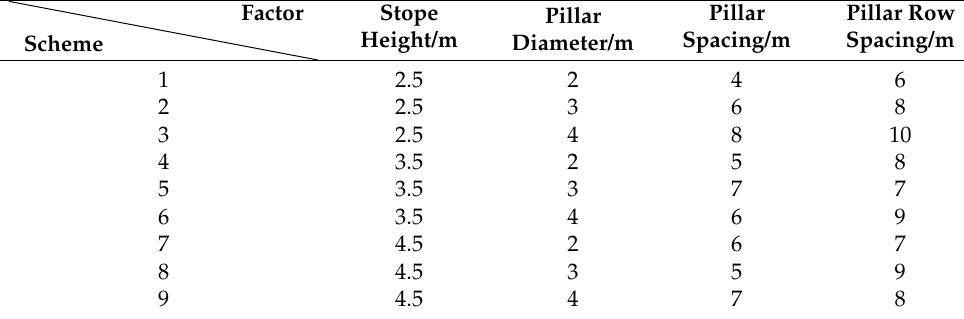
Table 3. Nine optimization schemes for orthogonal